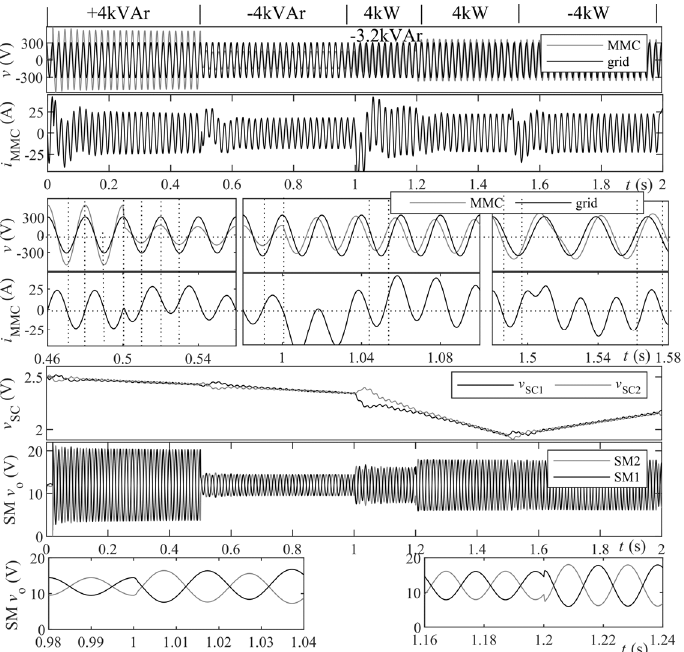
Figure 13. Delivering or absorbing active or reactive power in buck-mode with zoomed sections.